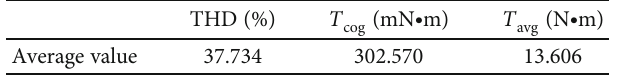
Table 3: Nonstandard orthogonal experimental matrix.